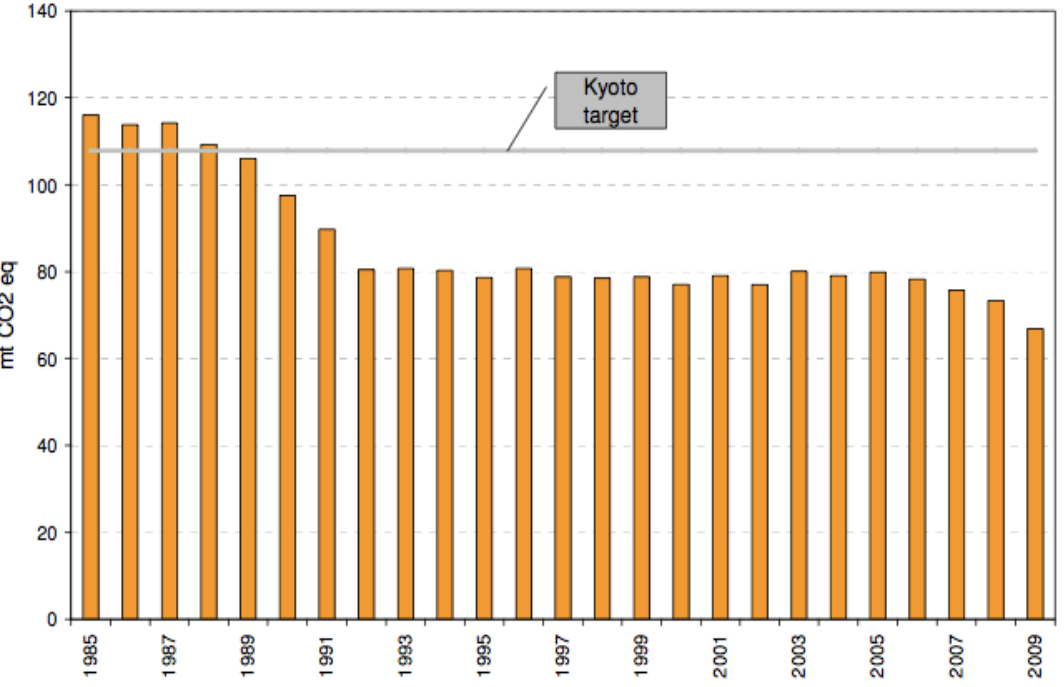
Figure 6. Hungary’s GHG emission by sectors in 2009 (thousand tones, CO